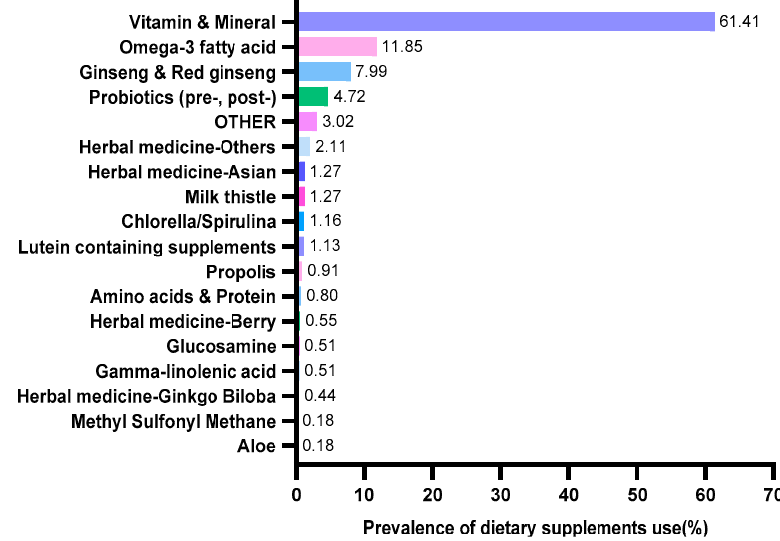
Figure 2. Prevalence of dietary supplements usage categories by Korean adults.